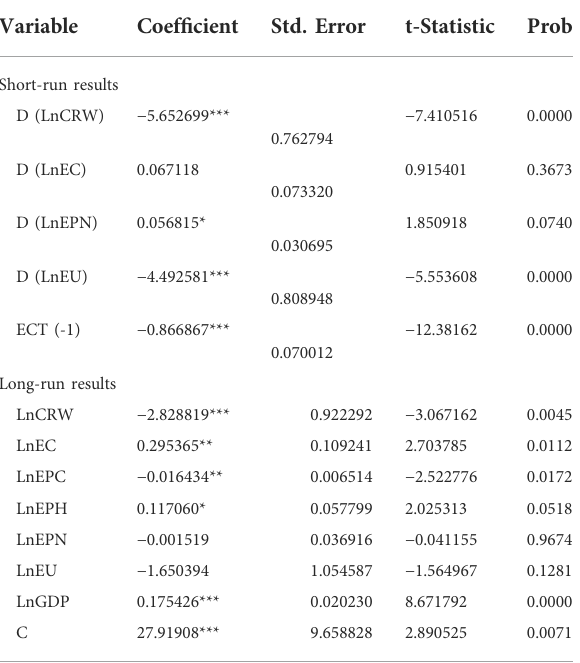
TABLE 9 Short-run and long-run relationship estimates ARDL